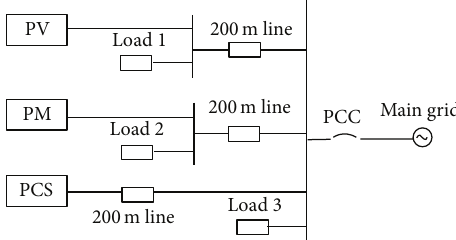
Figure 5: Schematic diagram of the